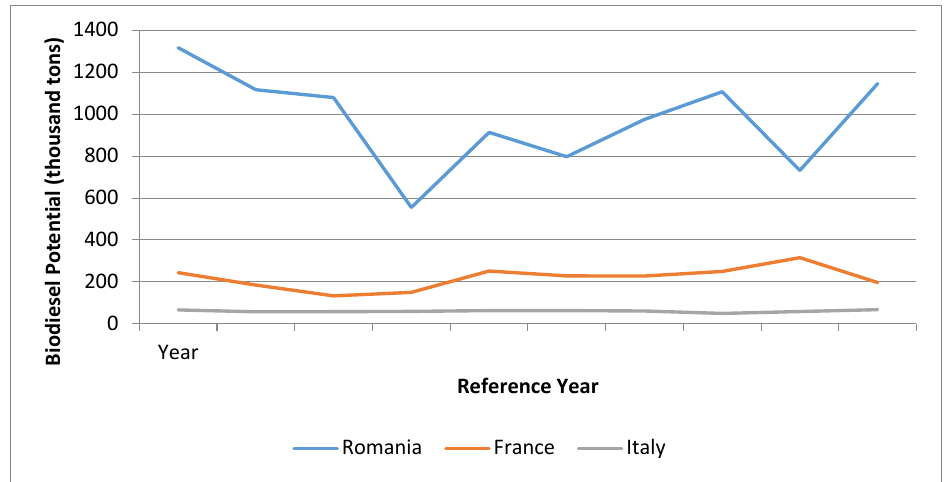
Figure 8. Biodiesel potential variation. Source: authors’ own computation based on [56].